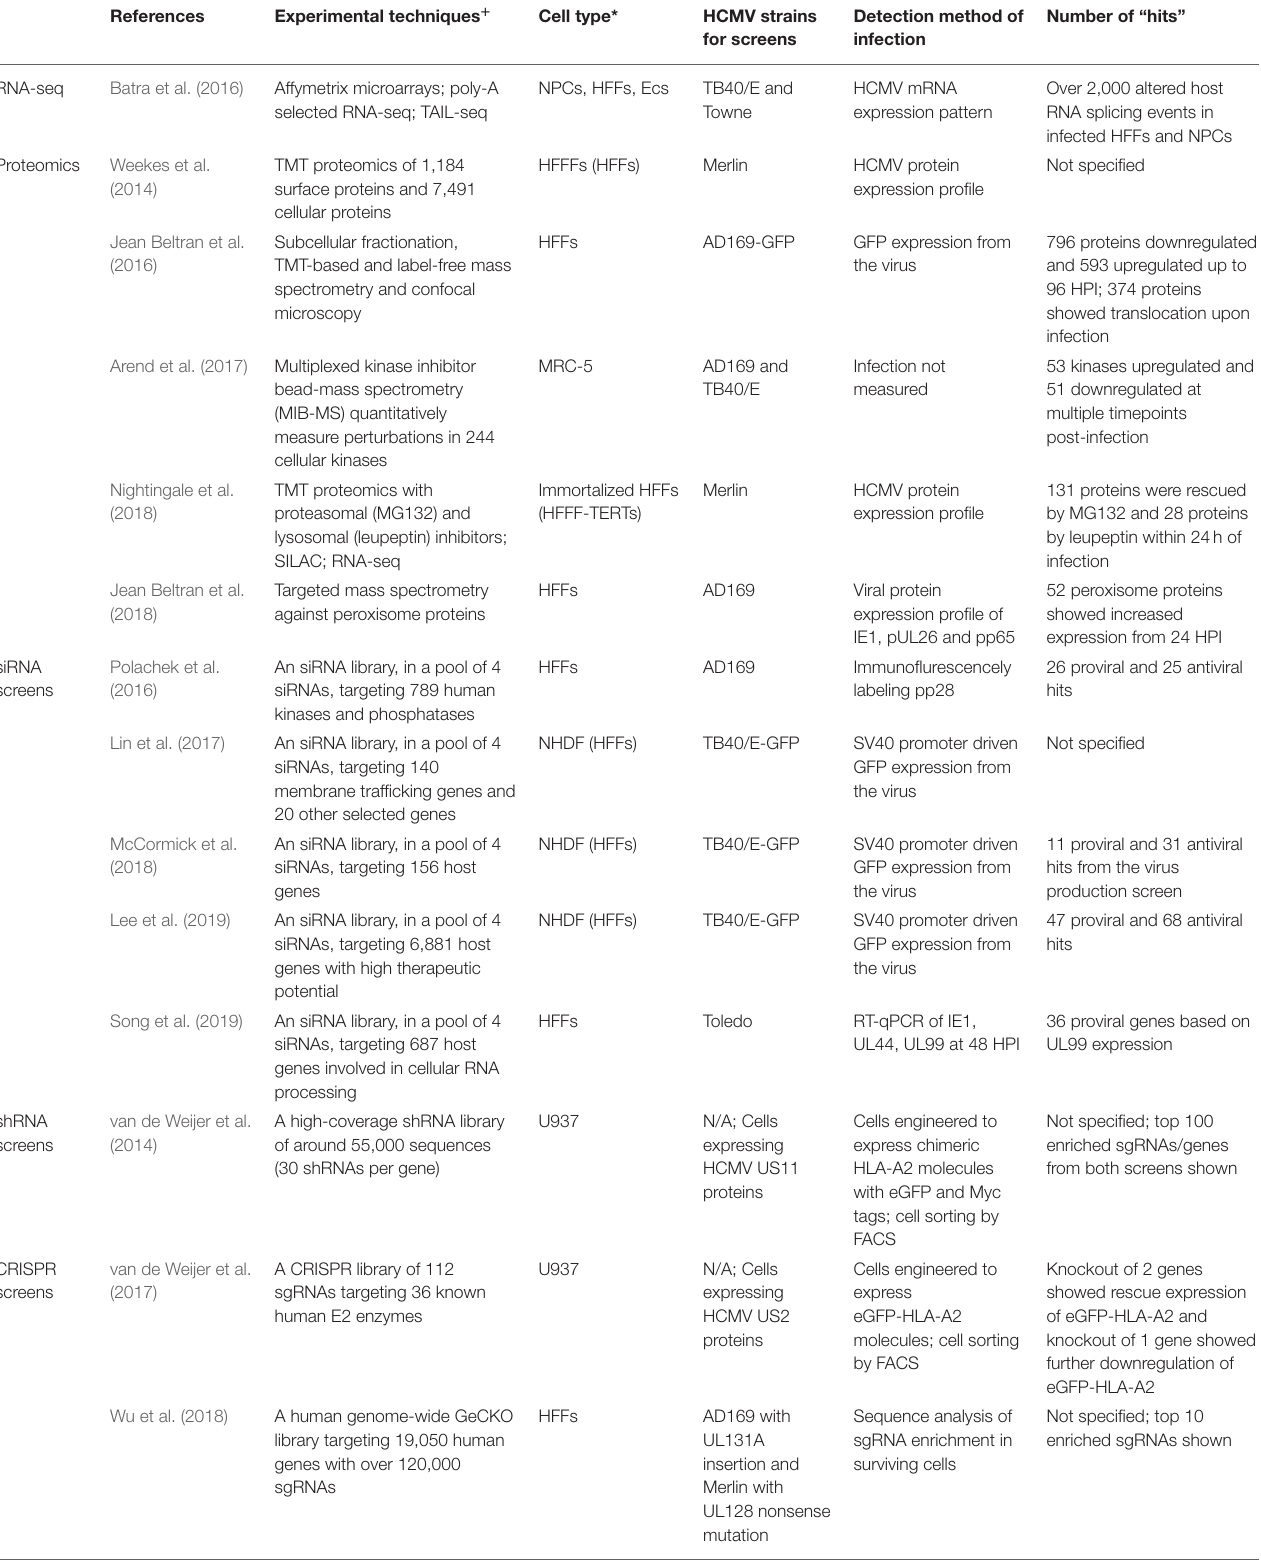
TABLE 1 | Summary of high-throughput